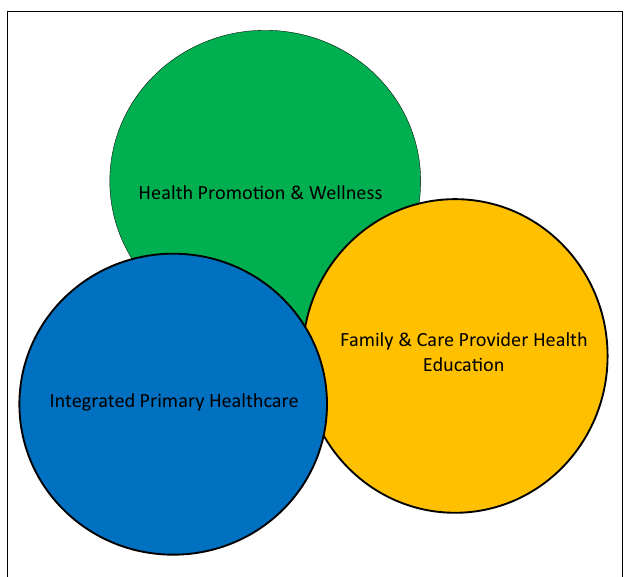
FIGURE 3 |The major components of healthcare delivery .